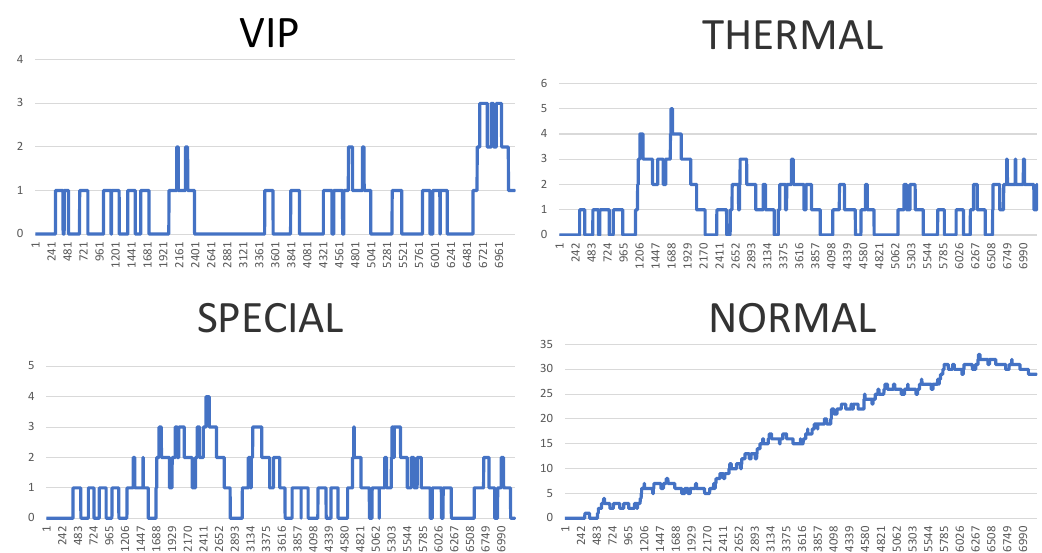
Figure 12. Results of the simulation processes carried out, or queue loads over the simulation time—very high mode. (Horizontal axes show the passing of simulation time from 0 to approx. 7000 s, vertical axes illustrate the current number of clients in particular